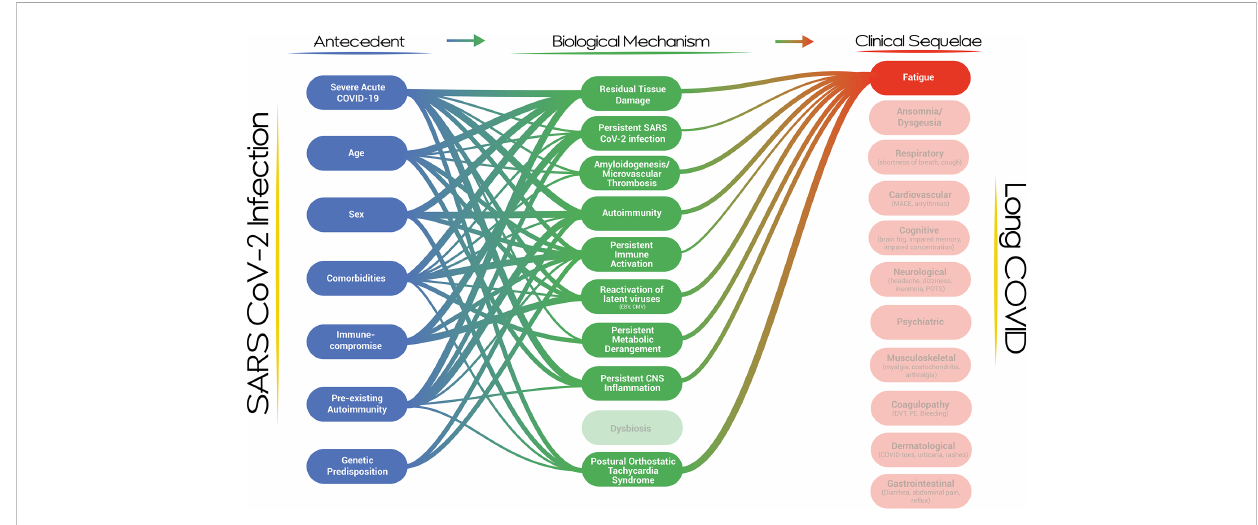
FIGURE 3 A network map of the risk factors and biological mechanisms associated with the development of fatigue in the context of Long